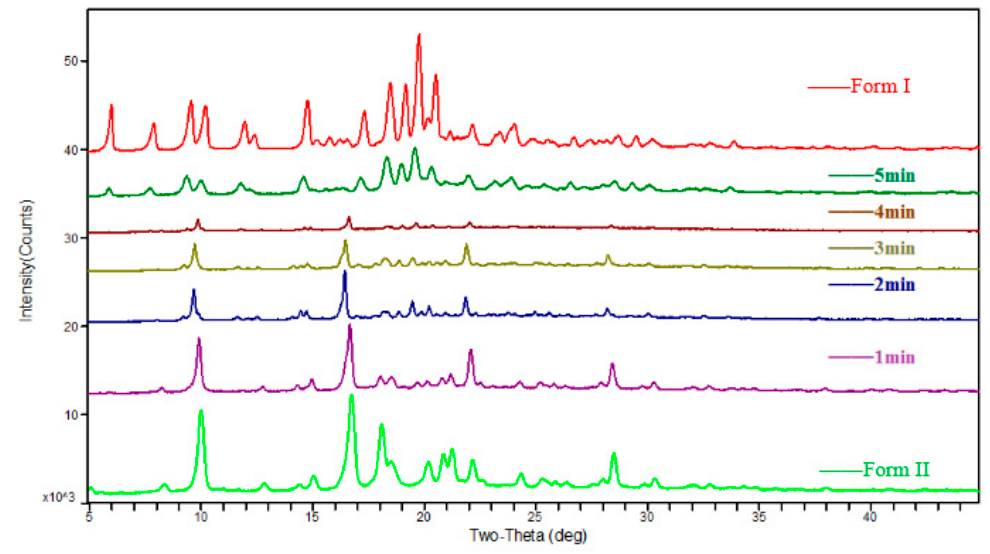
Figure 8. Comparison diagram of XRPD during the transformation process in Experiment #4. Table 3. Experimental conditions and parameters.